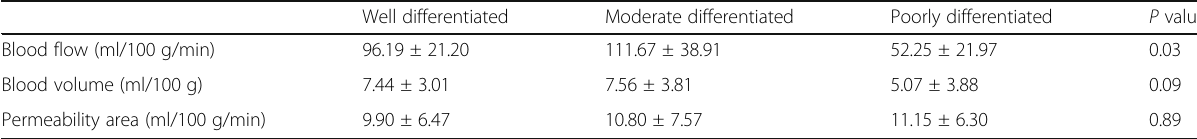
Table 1 Correlation of the CT perfusion parameters to the grade of colorectal cancer at the tumor edge using 30 mm 2 ROI